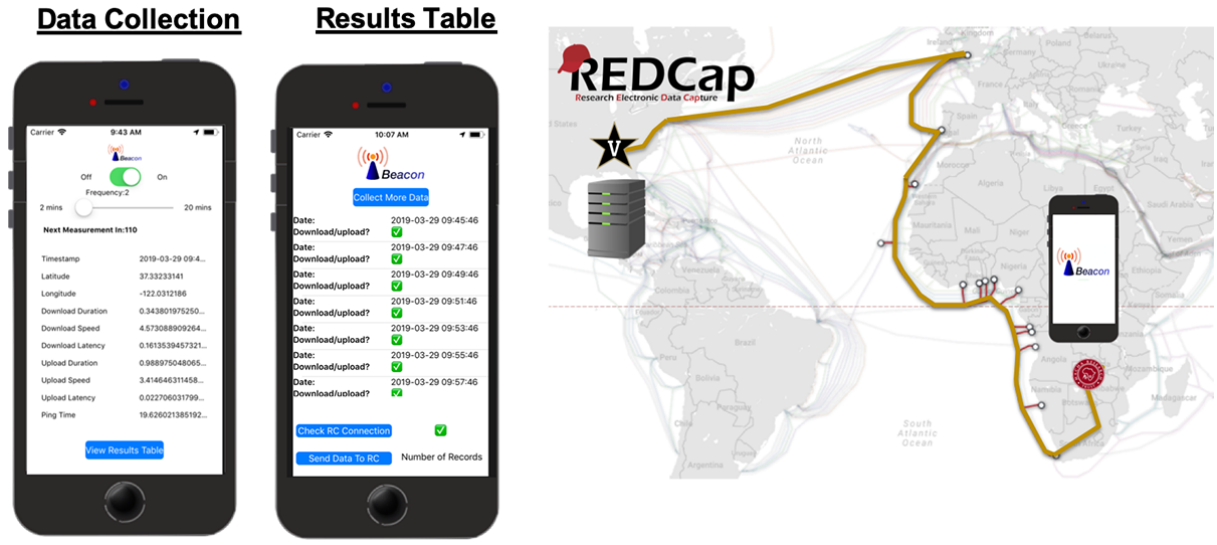
Figure 2. (Left) The two main screens in the Beacon app: the data collection screen and the results table and data transmission screen. (Right) A representative signal trace from the Macha Research Trust to Vanderbilt University, adapted from [13]. Using Beacon, files were downloaded and uploaded to a server at Vanderbilt University. After sufficient data aggregation, data were transferred to REDCap for storage. REDCap: Research Electronic Data